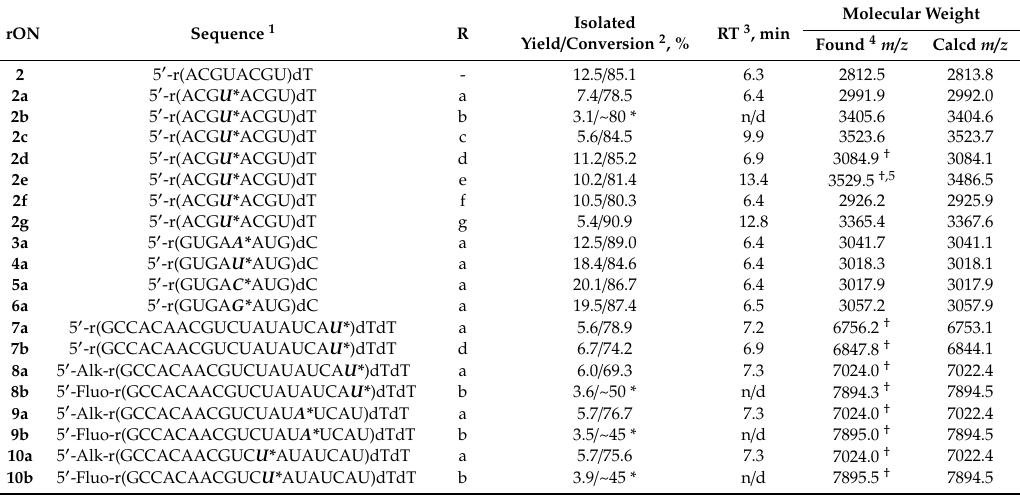
Table 1. 2 (cid:48) conjugates of oligoribonucleotides obtained in this study and their characteristics 1 .